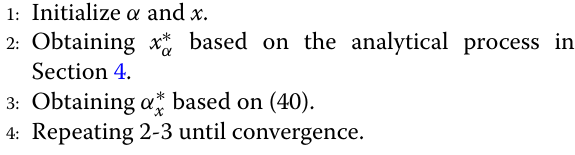
Algorithm 1 The Proposed Alternating Optimization